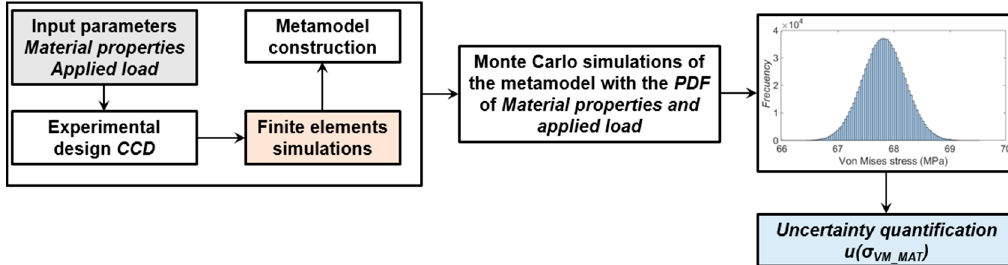
Figure 11. Uncertainty quantification procedure of the computational stress due to materials properties and load.